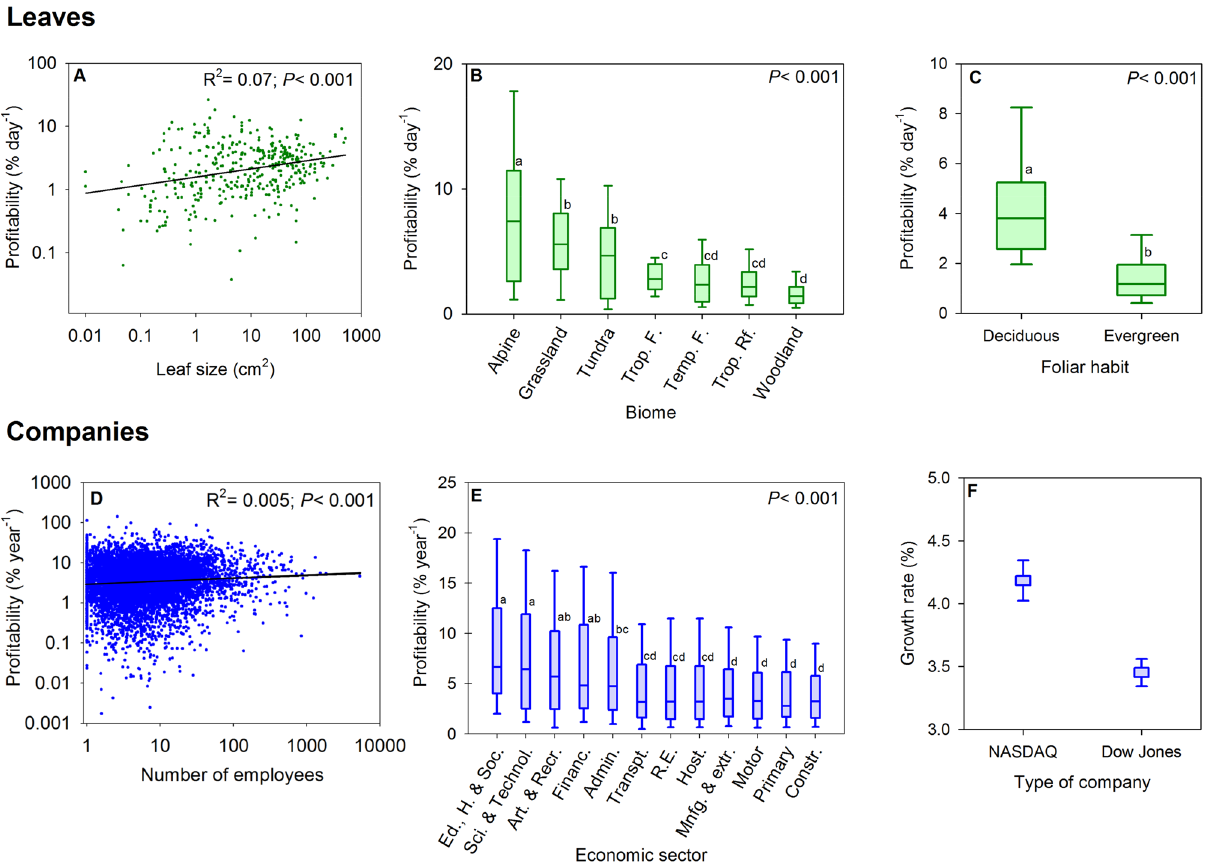
Figure 2. Profitability of leaves and companies in relation to size, environment and durability. For leaves, ( A ) relationships of profitability and leaf size, ( B ) comparison of leaf profitability in different biomes and ( C ) leaf profitability of two different leaf habits (deciduous, short leaf life-span and evergreen, long leaf life- span). Biomes: Alpine, Grasslands, Tundra, Tropical seasonal forest (Trop. F.), Temperate forest (Temp. F.), Tropical rain forest (Trop. RF.), Woodland. For companies, ( D ) relationships of profitability and company size (number of employees), ( E ) comparison of profitability of the different economic sectors (see codes below) and ( F ) average growth rates (similar to profitability) between different types of companies according to technology: NASDAQ companies (technology companies, short-term longevity); and Dow Jones companies (traditional companies, high longevity). Growth rates were calculated as the slope of the trend of market value (see Supplementary File S6 File). Economic sectors: Education, health and social services (Ed., H. & Soc.), Professional, scientific and technical activities (Sci. & Technol.), Artistic, recreational activities and other services (Art. & Recr.), Information and communication and financial and insurance activities (Financ.), Administrative activities and auxiliary services (Admin.), Transportation and storage (Transpt.), Real estate activities (R.E.), Hostelry (Host.), Manufacturing, extractive industries and energy and water supply (Mnfg. & extr.), Retail and wholesale trade and repair of motor vehicles (Motor), Primary (Primary), Construction (Constr.). The box in each plot shows the median and the lower and upper quartile, and the whiskers show the 10 and 90th